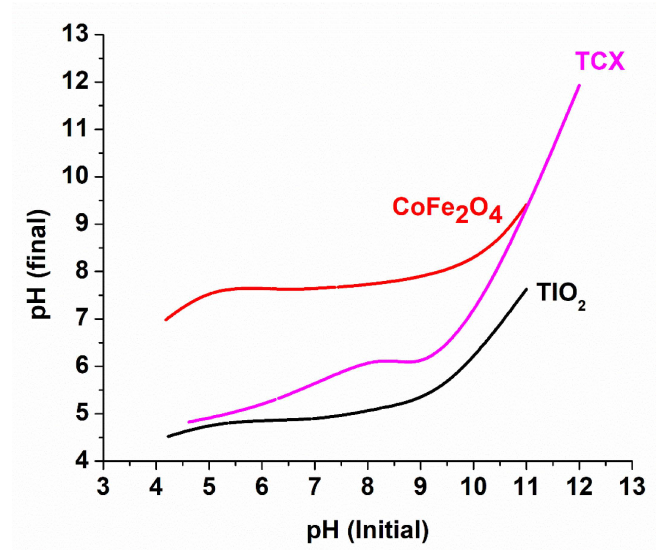
Figure 7. pHinitial vs. pHfinal curves for ZCP determination.